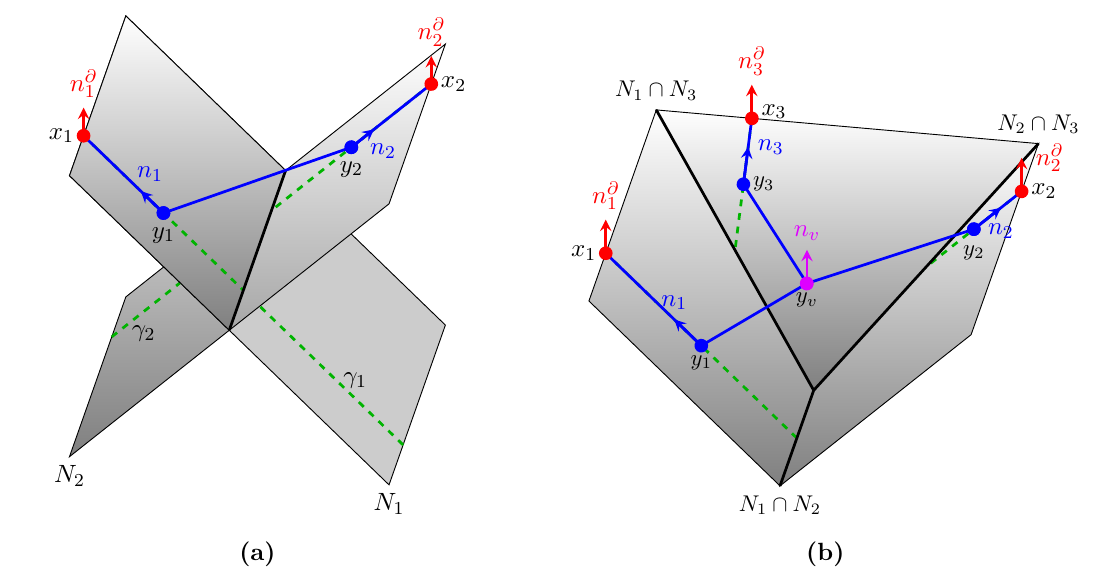
Figure 5. a) Set-up for the calculation of the holographic spinning two-point function. The red points are located at the null boundary at x i =1 ; 2 , equipped with boundary vectors n @ = @ u . The i regulated blue points are located at (cid:13) i , and they are equipped with blue vectors n i = @ r j y . The i spinning particle propagates between the blue points, along the green straight line connecting (cid:13) 1 and (cid:13) 2 . b) Set-up for the calculation of the holographic spinning three-point function. There are three boundary points drawn in red, and their regulated bulk versions are drawn in blue. At each blue point we have a blue vector n i =1 ; 2 ; 3 = @ r j y pointing along the null geodesics (cid:13) i . The spining i particles meet at a common purple point y v , where we have a purple time-like vector n v for which the spinning total on-shell action must be